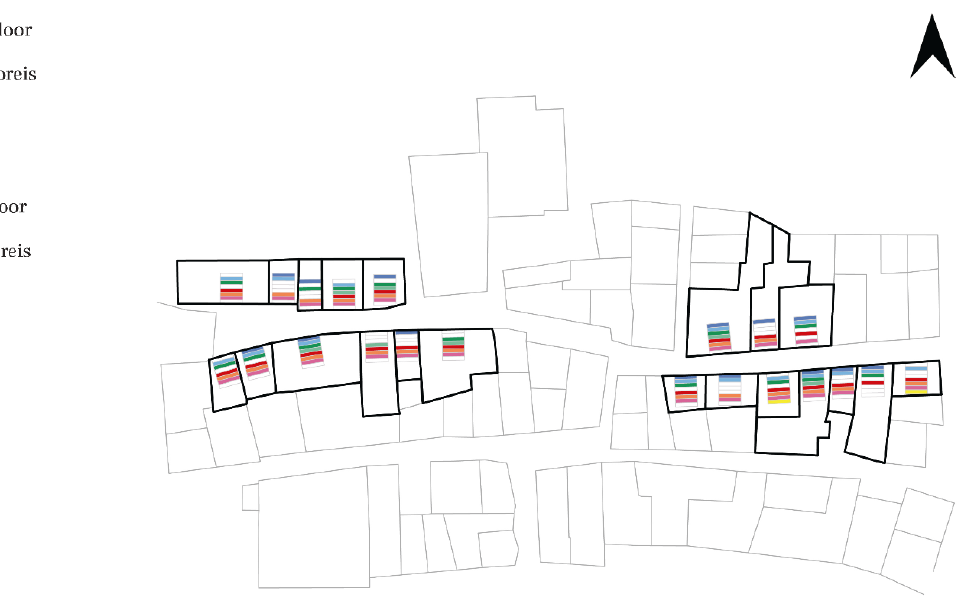
Figure 3. Data retrieved and digitally collected in a geospatial database using GIS software. An ex- ample from Cuenca. Phase 4 (2021). Source: Author.